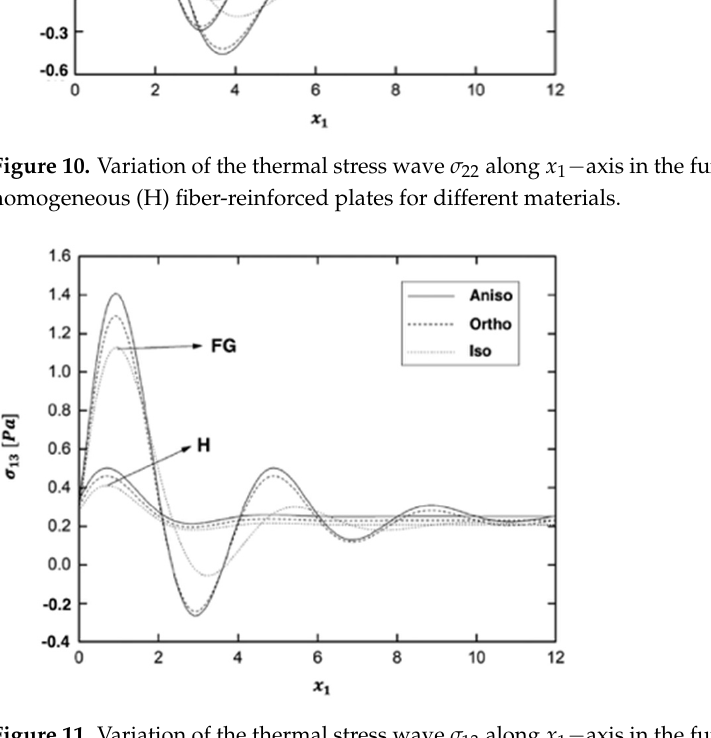
Figure 11. Variation of the thermal stress wave σ 13 along x 1 − axis in the functionally graded (FG) and homogeneous (H) fiber-reinforced plates for different materials.